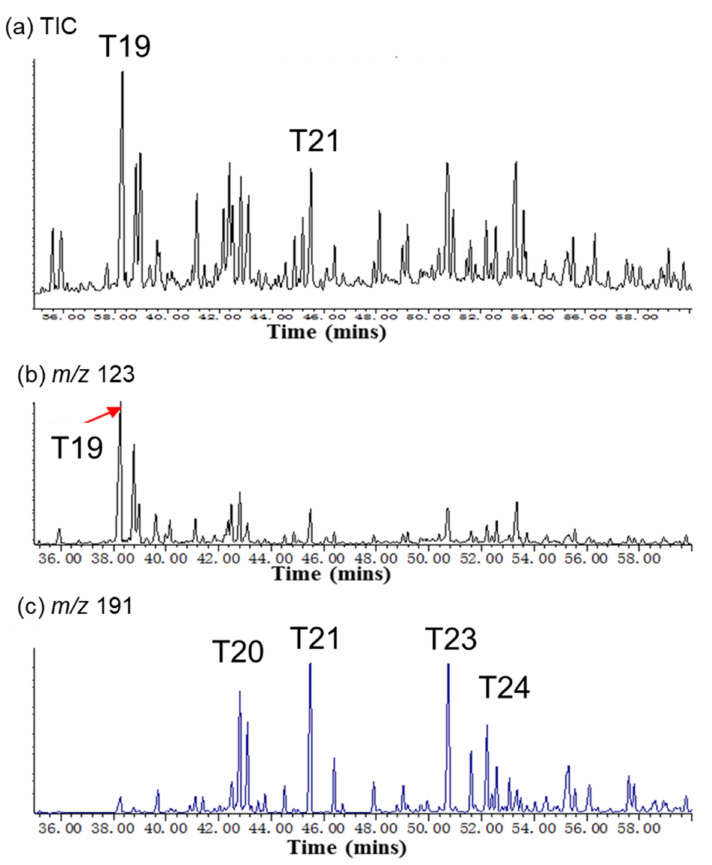
Figure 7. GC–MS analysis of extract (residual oil) with artificial maturation temperature at 300 ◦ C,